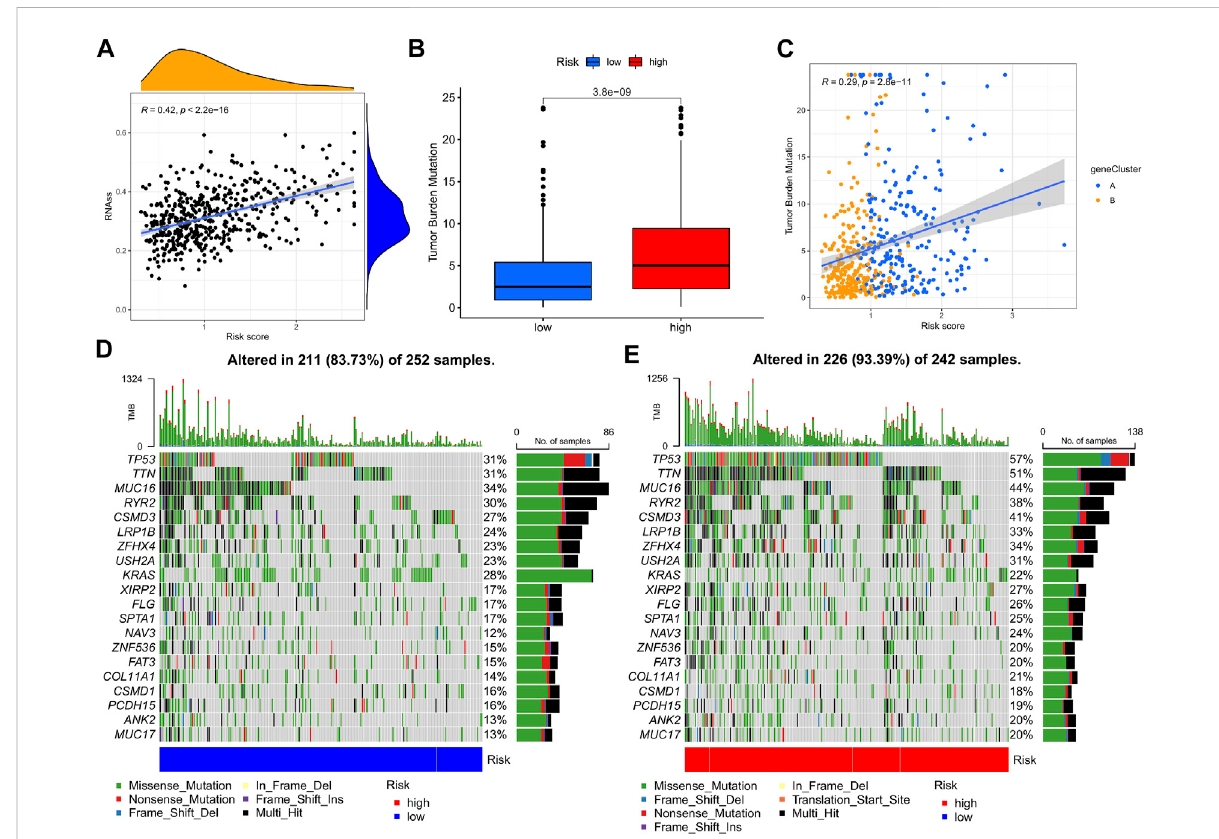
FIGURE 10 Cancerstemnessandmutationanalysis. (A) Associationofthem7G-Riskscorewithcancerstemness. (B) Associationofthem7G-Riskscorewith TMB. (C) Spearman ’ s correlation between the m7G-Riskscore and TMB. (D – E) Waterfall plots of somatic